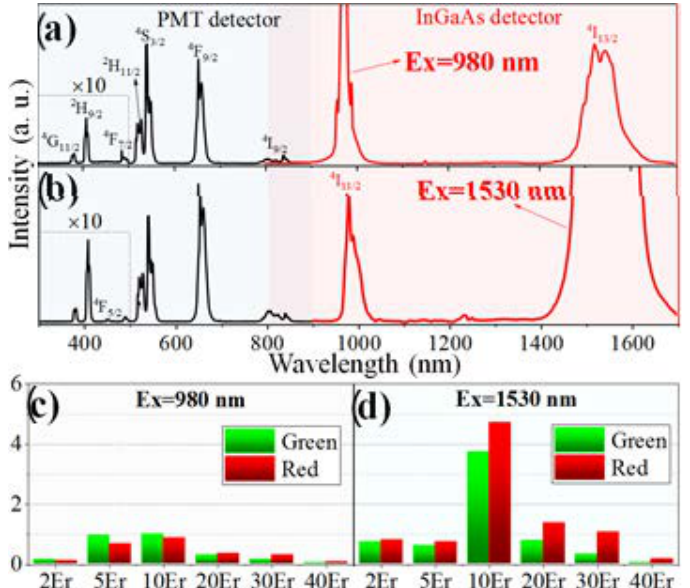
Figure 3. Photoluminescence spectra of 10Er sample upon ( a ) 980 and ( b ) 1530 nm excitation. The spectra in the wavelength range of 300~500 nm were enlarged by a factor of 10, for the sake of clarity; ( c , d ) are the histograms of the overall intensities of green and red UC emissions of different samples upon 980 and 1530 nm excitation, respectively, normalized by the green intensity of the 10Er